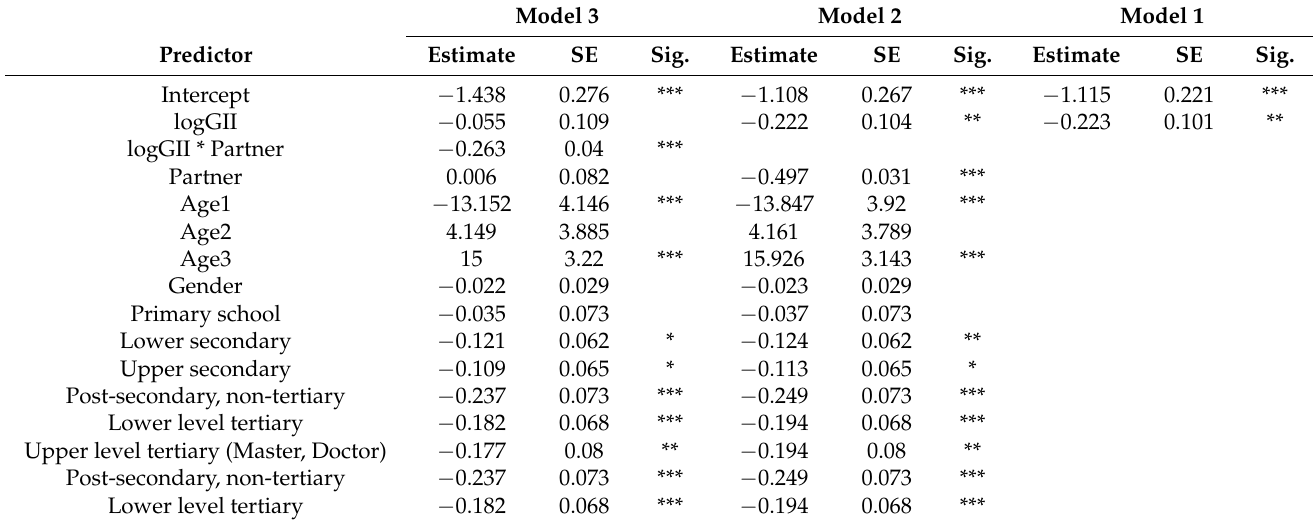
Table A2. Multilevel logistic regressions of the effect of GII on loneliness (Full Table